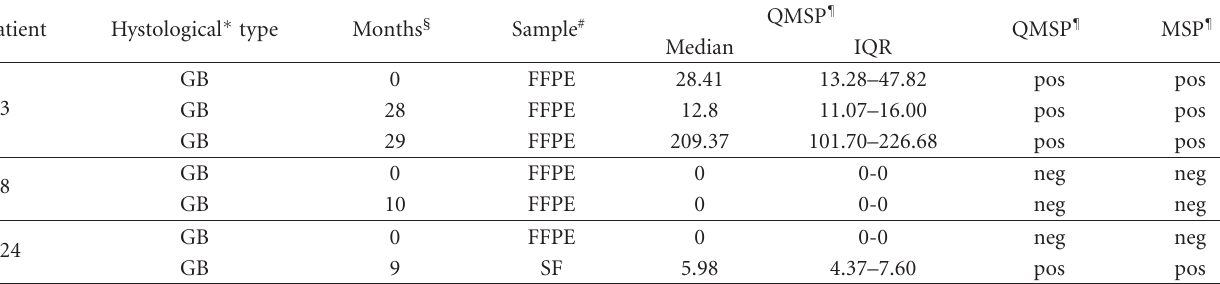
Table 2: MGMT promoter methylation status in primary tumour and recurrences by quantitative methylation-specific PCR (QMSP) and Methylation-Specific PCR